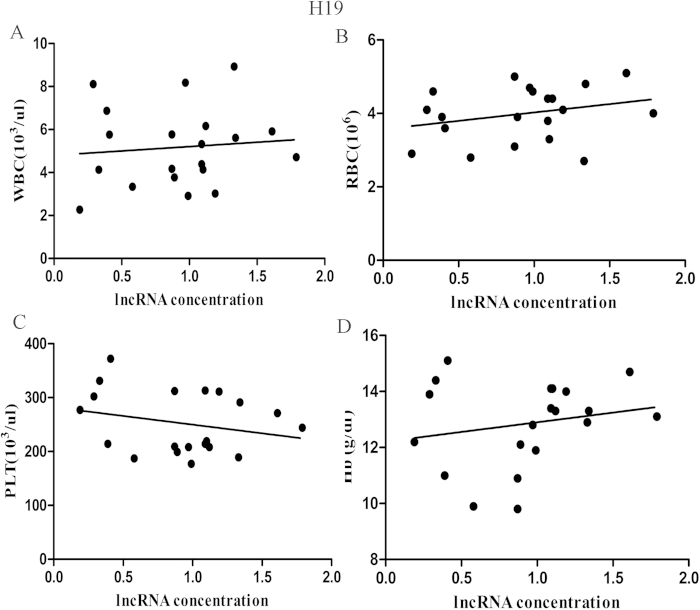
Correlation between plasma H19 concentrations and the haematocytes of peripheral blood in GC patients.There was no significant correlation between plasma H19 concentrations and any type of peripheral haematocytes and plasma (P > 0.05).